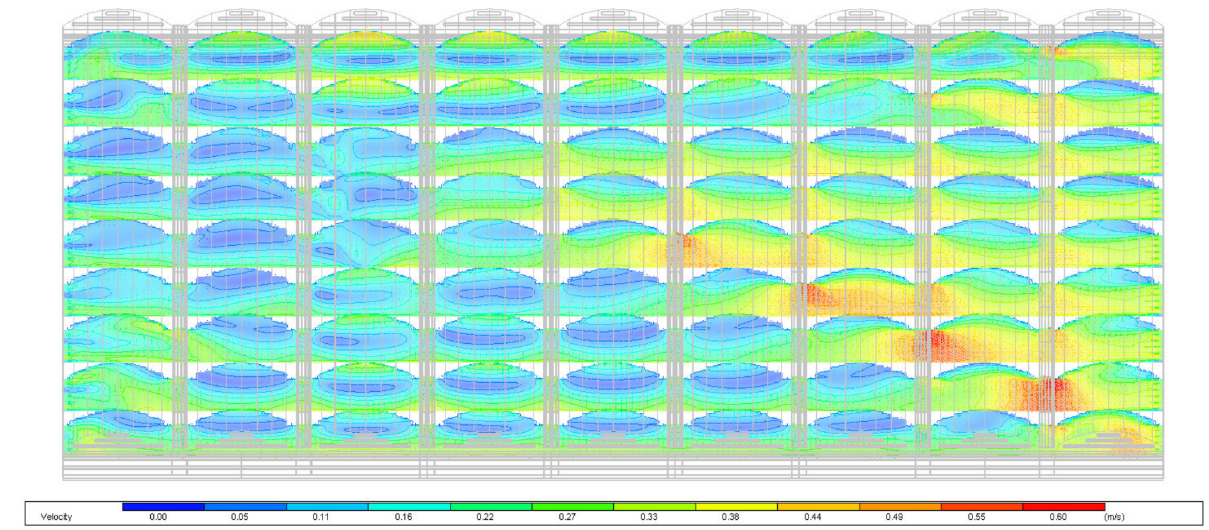
Figure 20. Wind speed cloud map of the multi-span round-arch greenhouse with an in-greenhouse ventilation channel (outdoor wind speed 1